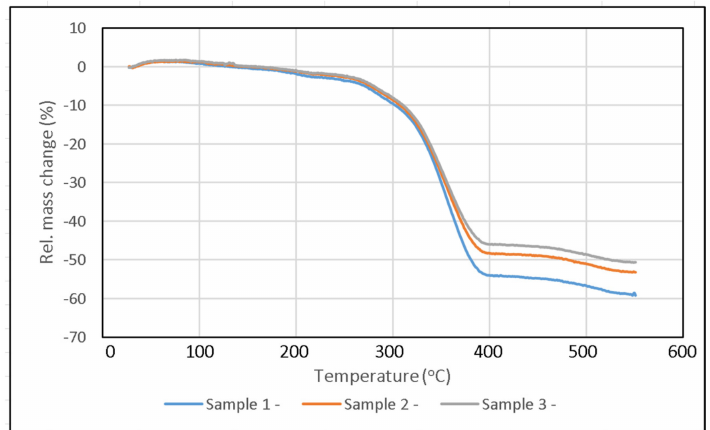
Figure 11. TGA curve